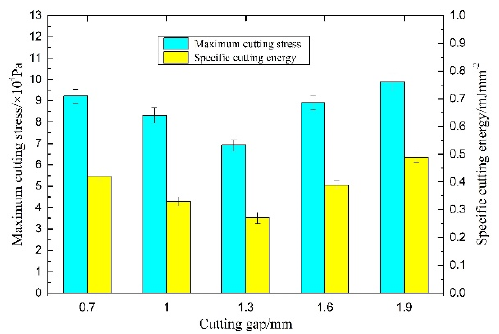
Figure 8. Results of the comparation test.